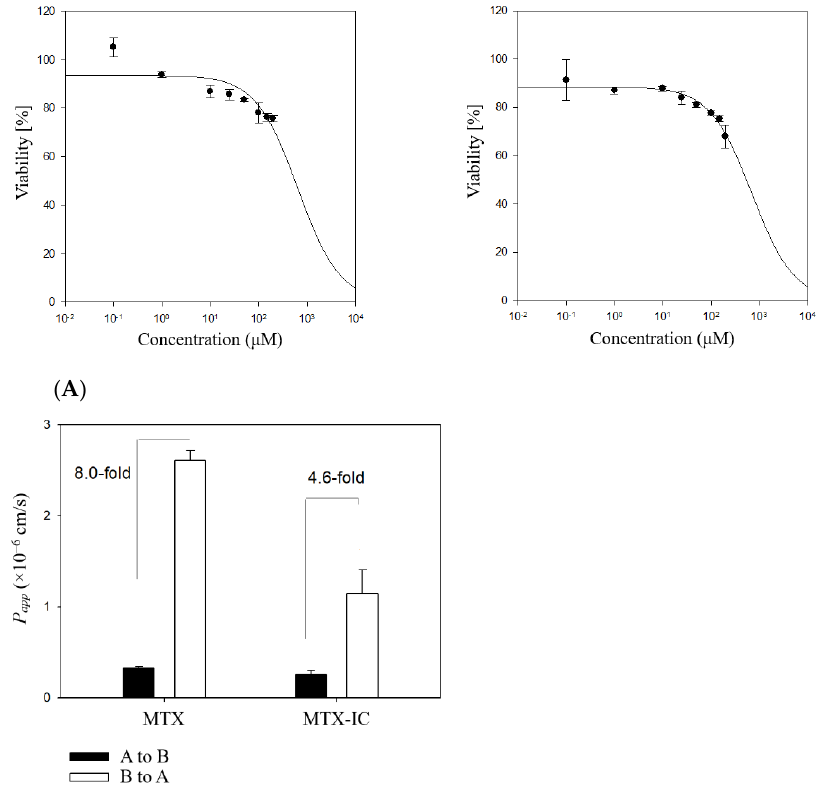
Figure 11. ( A ) Cytotoxic effect of MTX and the MTX/DM- β -CD inclusion complex (IC4) in Caco-2 cells ( n = 6); and ( B ) the cumulative amount of MTX transported from A to B and B to A in Caco-2